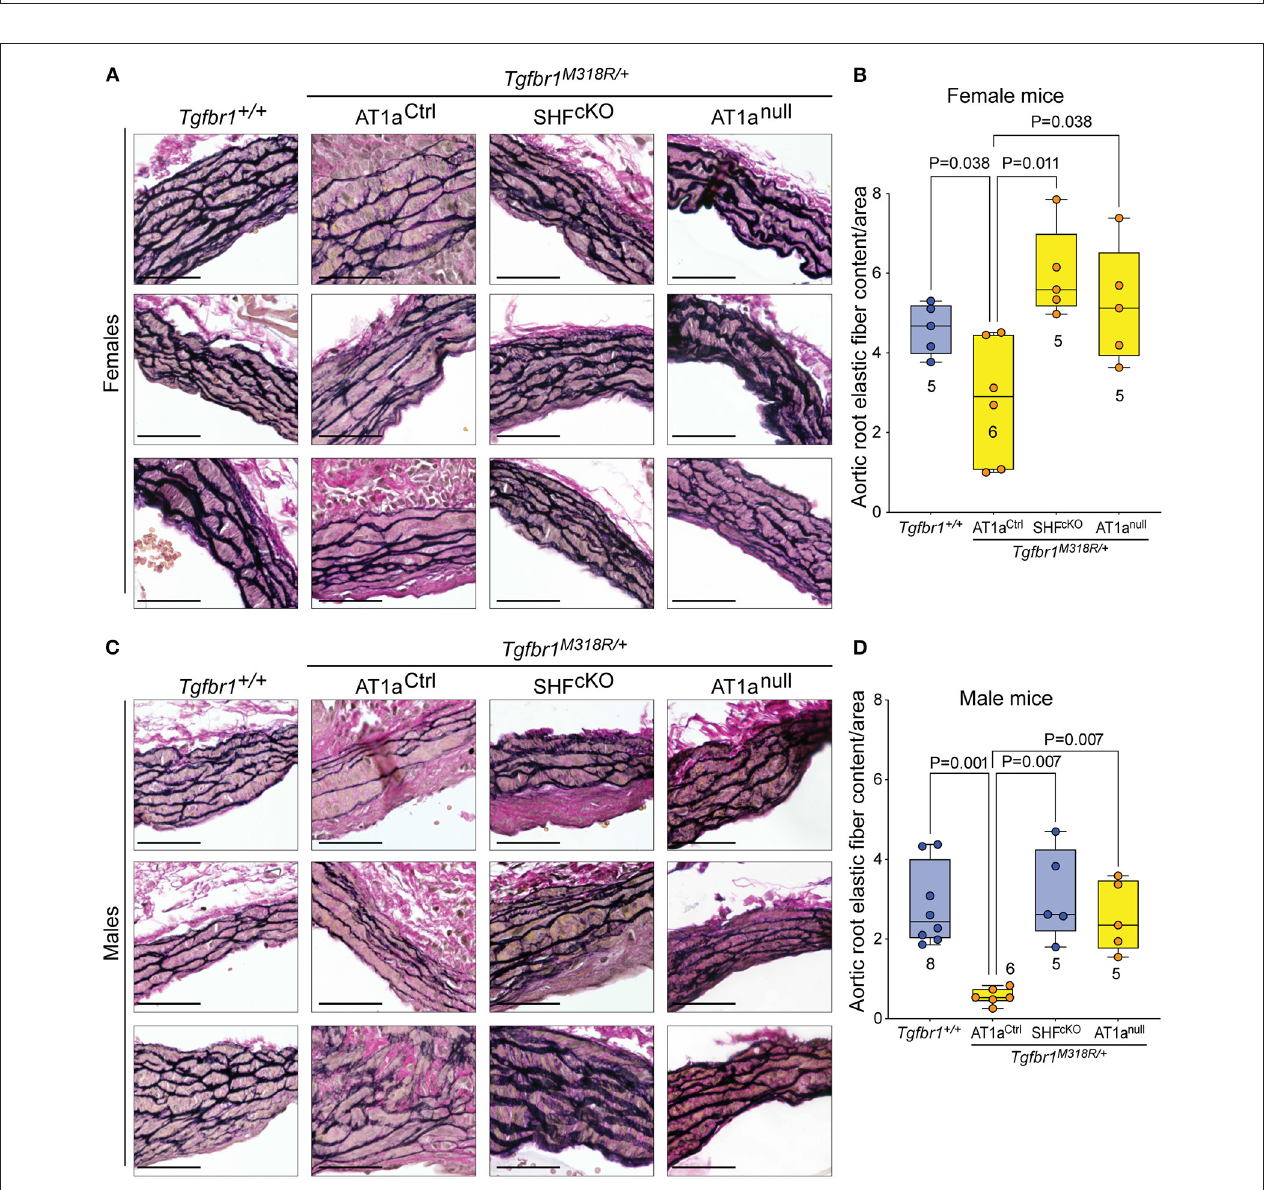
FIGURE 2 | Global and SHF-specific deletion of Agtr1a result in improved histopathology. Representative sections of VVG-stained aortic roots and quantification of elastic fiber content relative to cellular area for female (A,B) and male (C,D) samples of indicated genotypes. Three representative images are shown per genotype for each sex. Images are shown at 20 × magnification. Scale bar is 50 µ m. Quantification of elastic fiber content relative to cellular area is shown in (C) for female samples, and in (D) for male samples, with higher value indicating a greater content of elastic fiber per area unit. The number of mice scored per group is indicated. P -values refer to Brown-Forsythe ANOVA, followed by post-hoc test with multiple comparison FDR